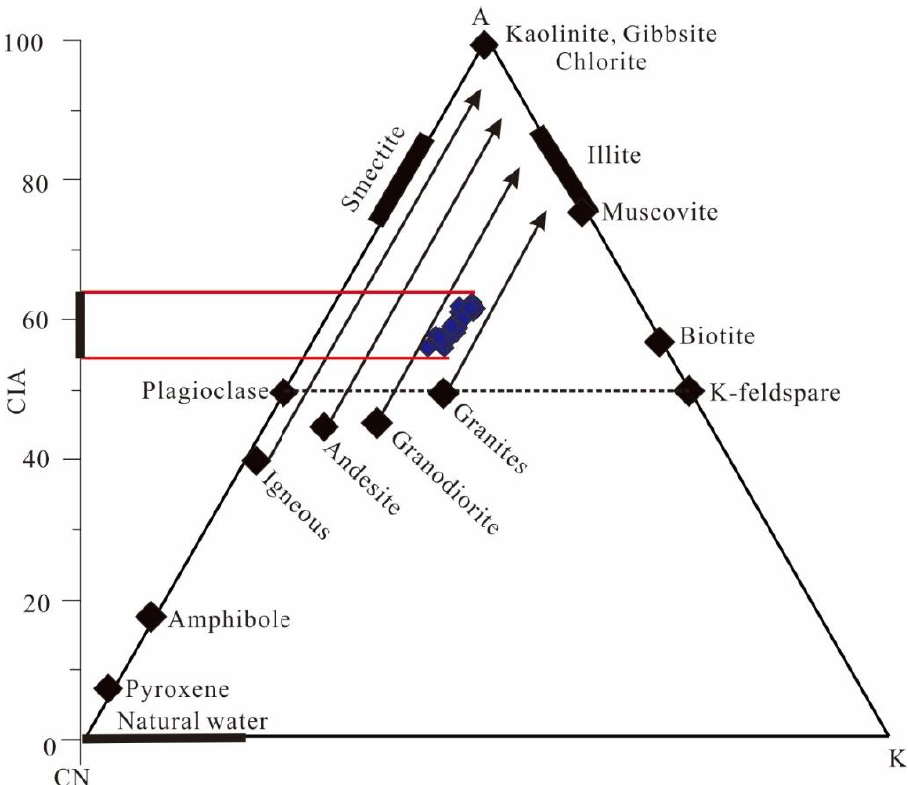
Figure 15. A-CN-K Ternary diagram for the Zhiluo Formation sandstones [30]: A = Al 2 O 3 ; CN = CaO* + Na 2 O; and K = K 2 O.